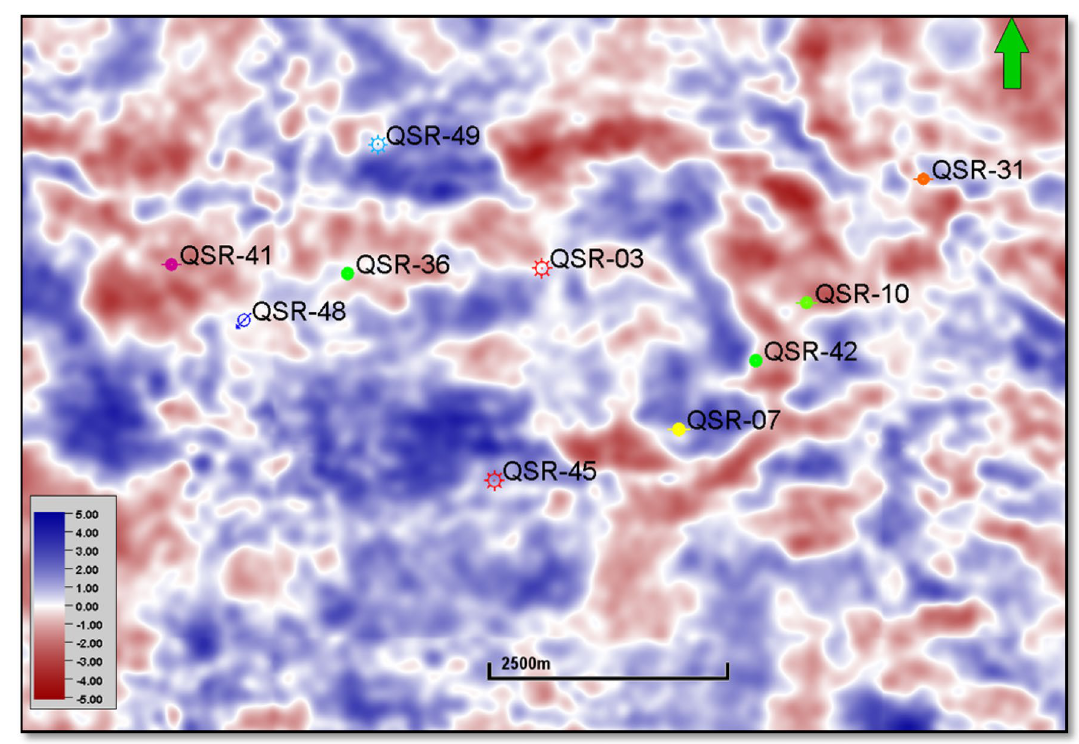
Fig. 16 Seismic horizontal section (time slice) at − 1995 ms. Note the gradational red–white–blue amplitude. Blue color for peak and red color for trough amplitudes